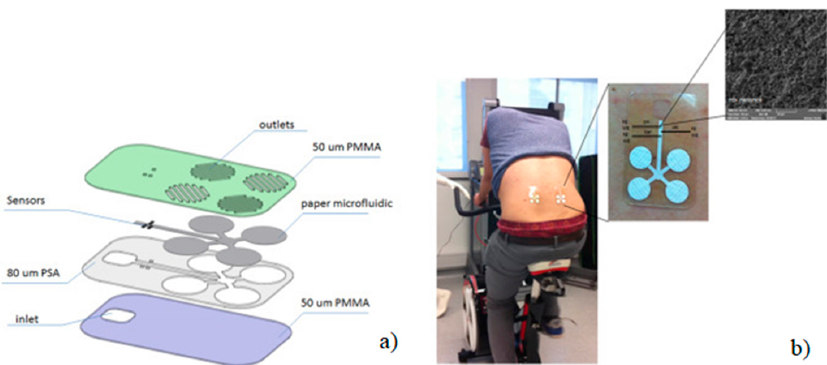
Figure 13. Schematic representation of the fabrication steps of the micro-fluidic chip on PMMA where ( a ) device layers, assembly and application on human sweat monitoring and ( b ) sensor structure and surface (Adapted with the permission of Elsevier)